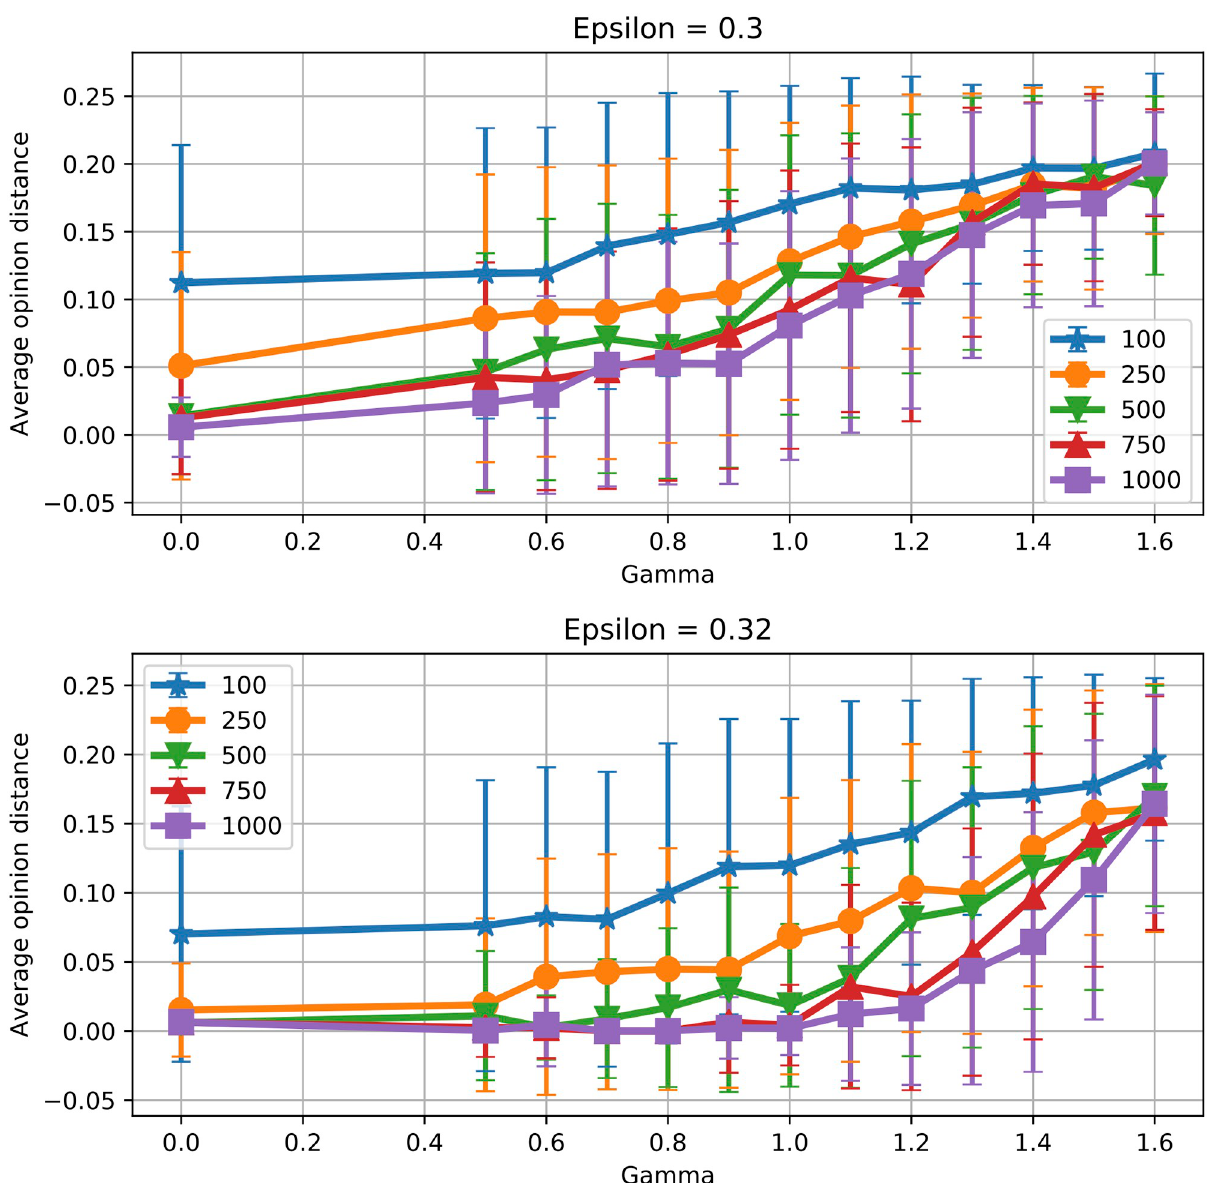
Fig 8. Finite size effects: Opinion distance with algorithmic bias. Mean opinion distance obtained for various ε , γ and N . Values are averaged over 200, 150, 100, 100 and 100 runs for N 2 {100, 250, 500, 750, 1000}, respectively. Error bars show one standard deviation from the mean.